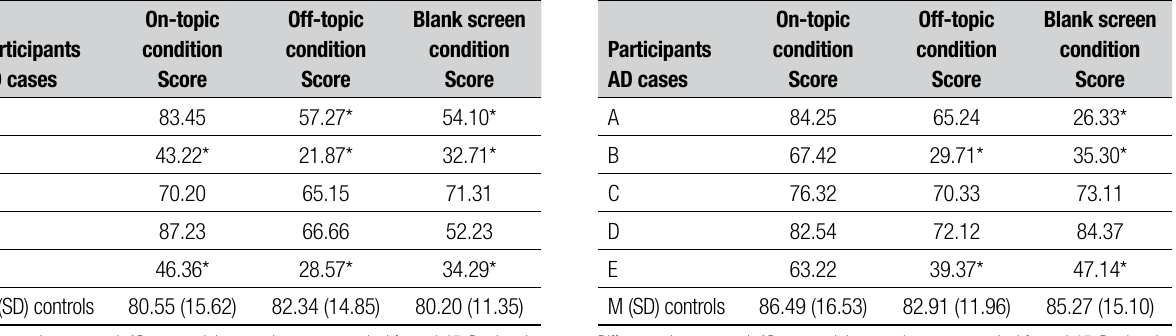
Table 2. Differences between cases and controls in global coherence scores. Table 3. Differences between cases and controls in terms of